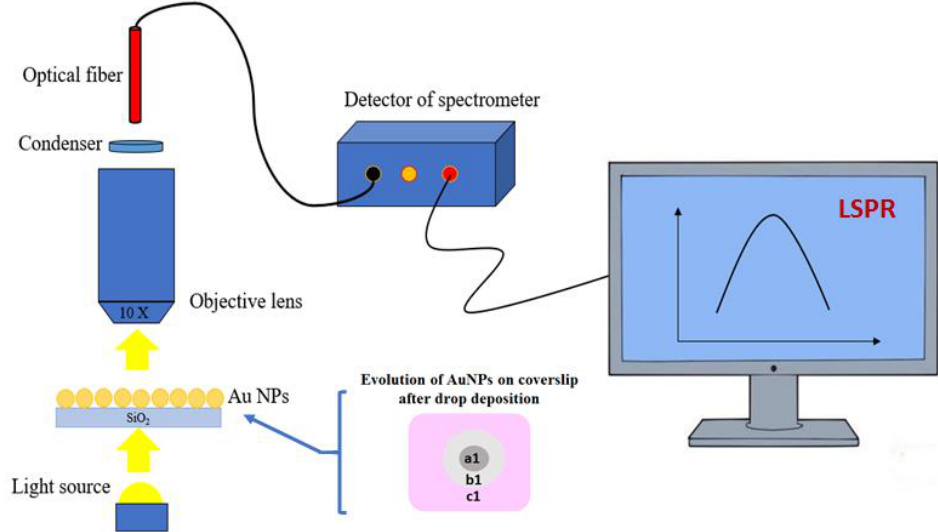
Figure 1. Set-up for localized surface plasmon resonance (LSPR) investigations of annealed gold nanoparticles (AuNPs) on coverslips exposed to drops of aqueous and saline buffers. Once the different drops of buffers were collected from the coverslips, three areas were observed and named a1 (under the drop), b1 (in the vicinity of the drop) and c1 (far from the drop).